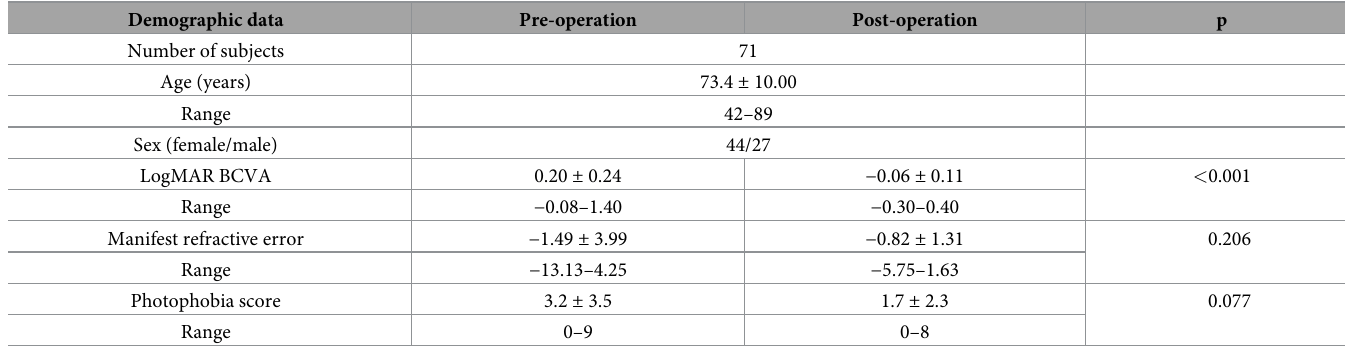
Table 1. Demographic data of this